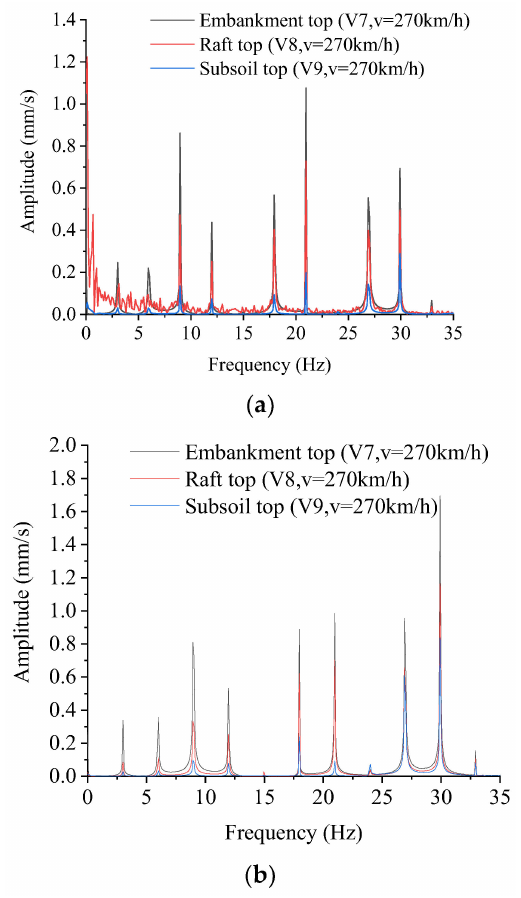
Figure 12. Frequency contents of vibration velocities at embankment top V7, raft top V8, and subsoil top V9. ( a ) Low water level, ( b ) High water level, v = 270